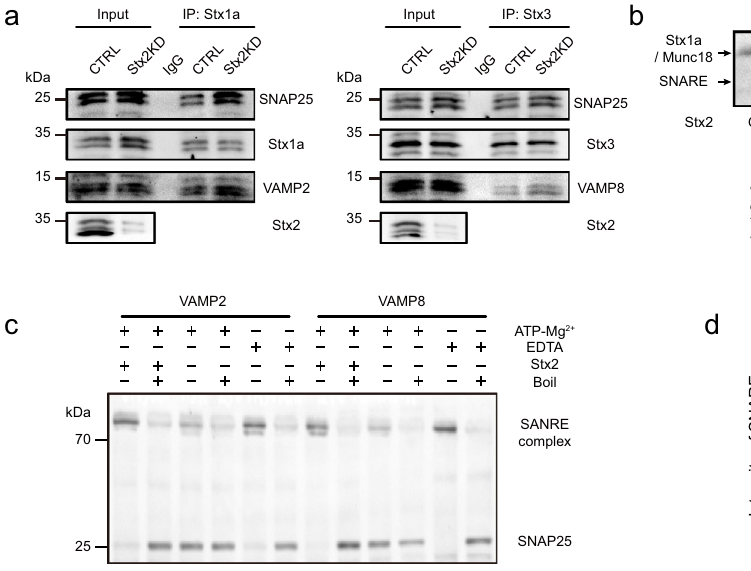
Fig. 3 | Stx2 deletionenhancesexocytosis by facilitating trans -SNAREcomplex assembly and cis -SNARE complex disassembly. a Stx2 deletion promotes the formation of profusion trans -SNARE complexes. SNARE complexes were co- immunoprecipitated (co-IP) from human islets lysates by antibody against Stx1a and Stx3. Native primary antibody-speci fi c secondary antibodies were used to eliminateinterferencebytheheavy-andlight-chainIgGfragmentsofinitialIPassay. Representative blots are shown in a and quanti fi cation shown in Supplementary Fig. 3a ( n =4 independent experiments). b Stx2 inhibits the transition of early assembly intermediates to fusogenic SNARE complexes by substituting for the fusogenicsyntaxins(Stx1a, Stx3)asdetectedbynative-PAGE.Samples wereloaded with 5× native loading buffer into 12% non-denaturing polyacrylamide gel without SDS. This is because Stx2 directly bound not only cognate SNAREs but also the